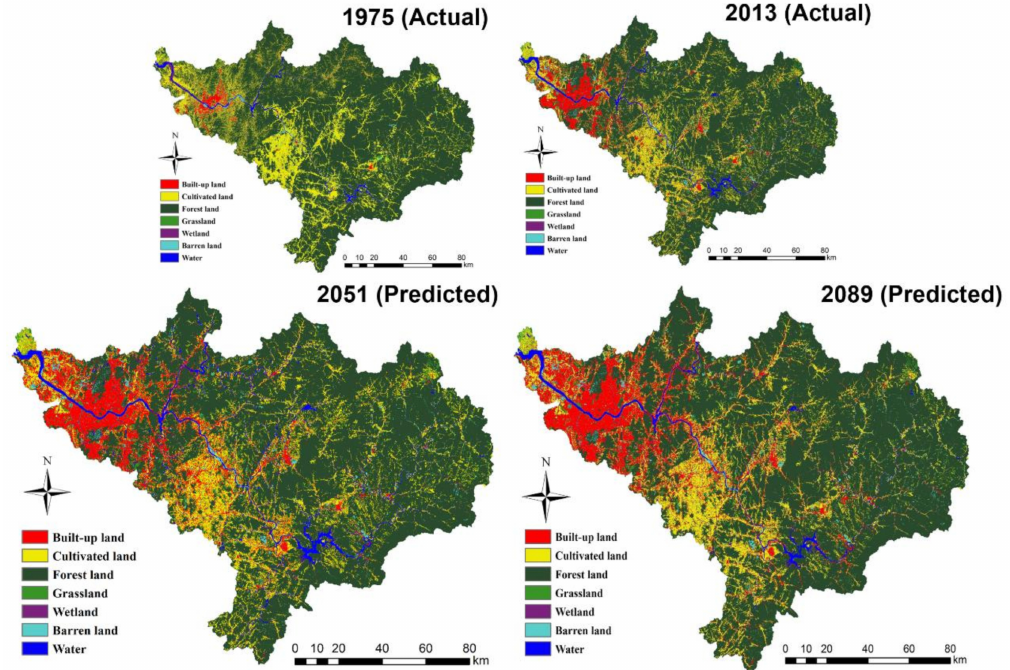
Figure 5. Actual land use map in 1975 and 2013 and predicted land use map in 2051 and